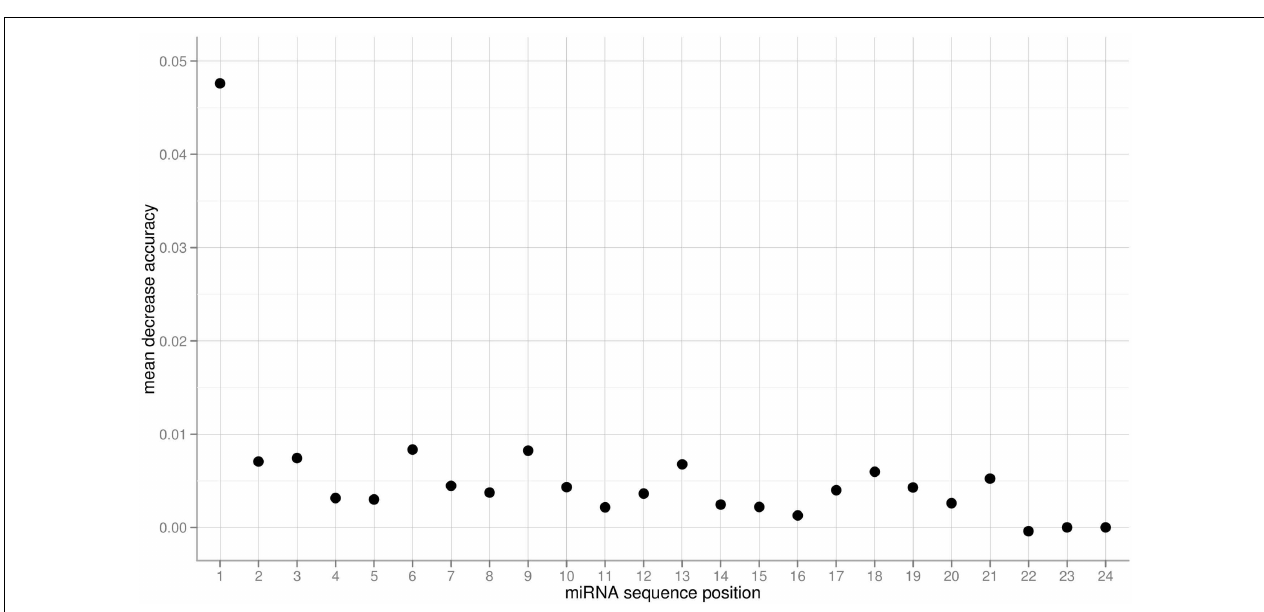
FIGURE 5 |Variable importance measure computed as the mean decrease of accuracy for the three-class RF prediction ofAGO sorting using the sequence information of miRNAs of the Confidence Set . Here, larger values indicate increased importance for the classification